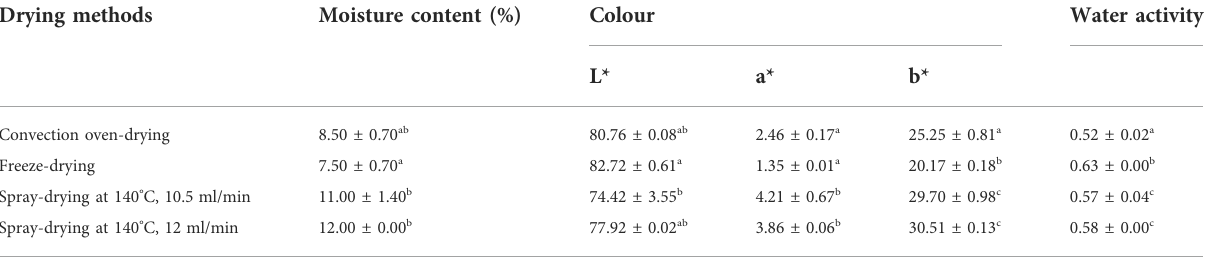
TABLE 2 Physicochemical properties of chamomile extract powder obtained from different drying methods.